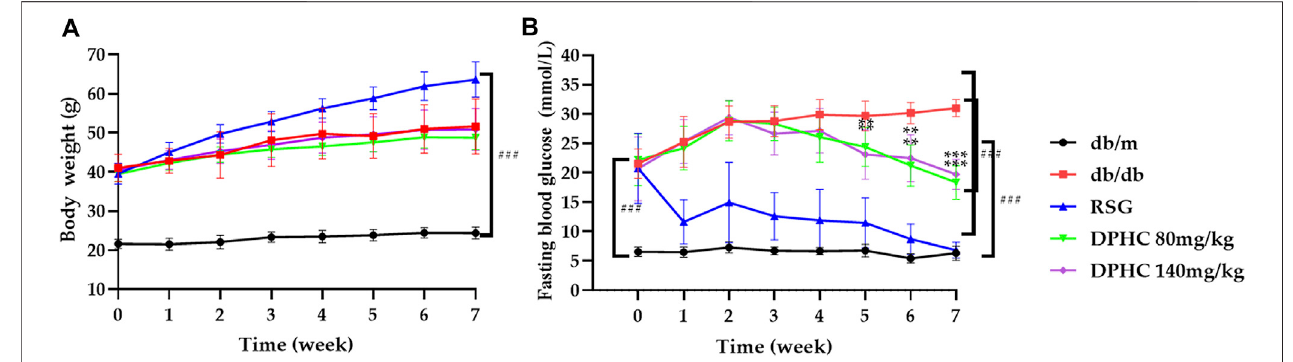
FIGURE 2 | Effects of DPHC on body weight and FBG. (A) Body weight. (B) FBG levels. All values are expressed as means ± SD, n (cid:1) 9. ** p < 0.01, *** p < 0.001 compared with the db/db group, and ### p < 0.001 compared with the db/m